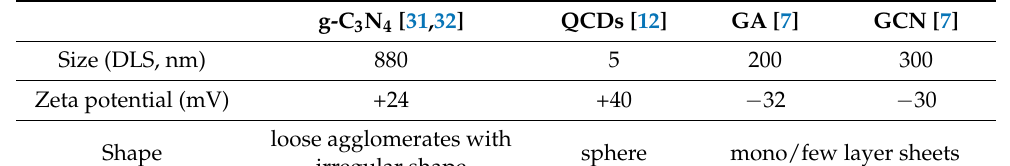
Table 1. Characterization of carbon nanomaterials g-C3N4, QCDs, GA and GCN.